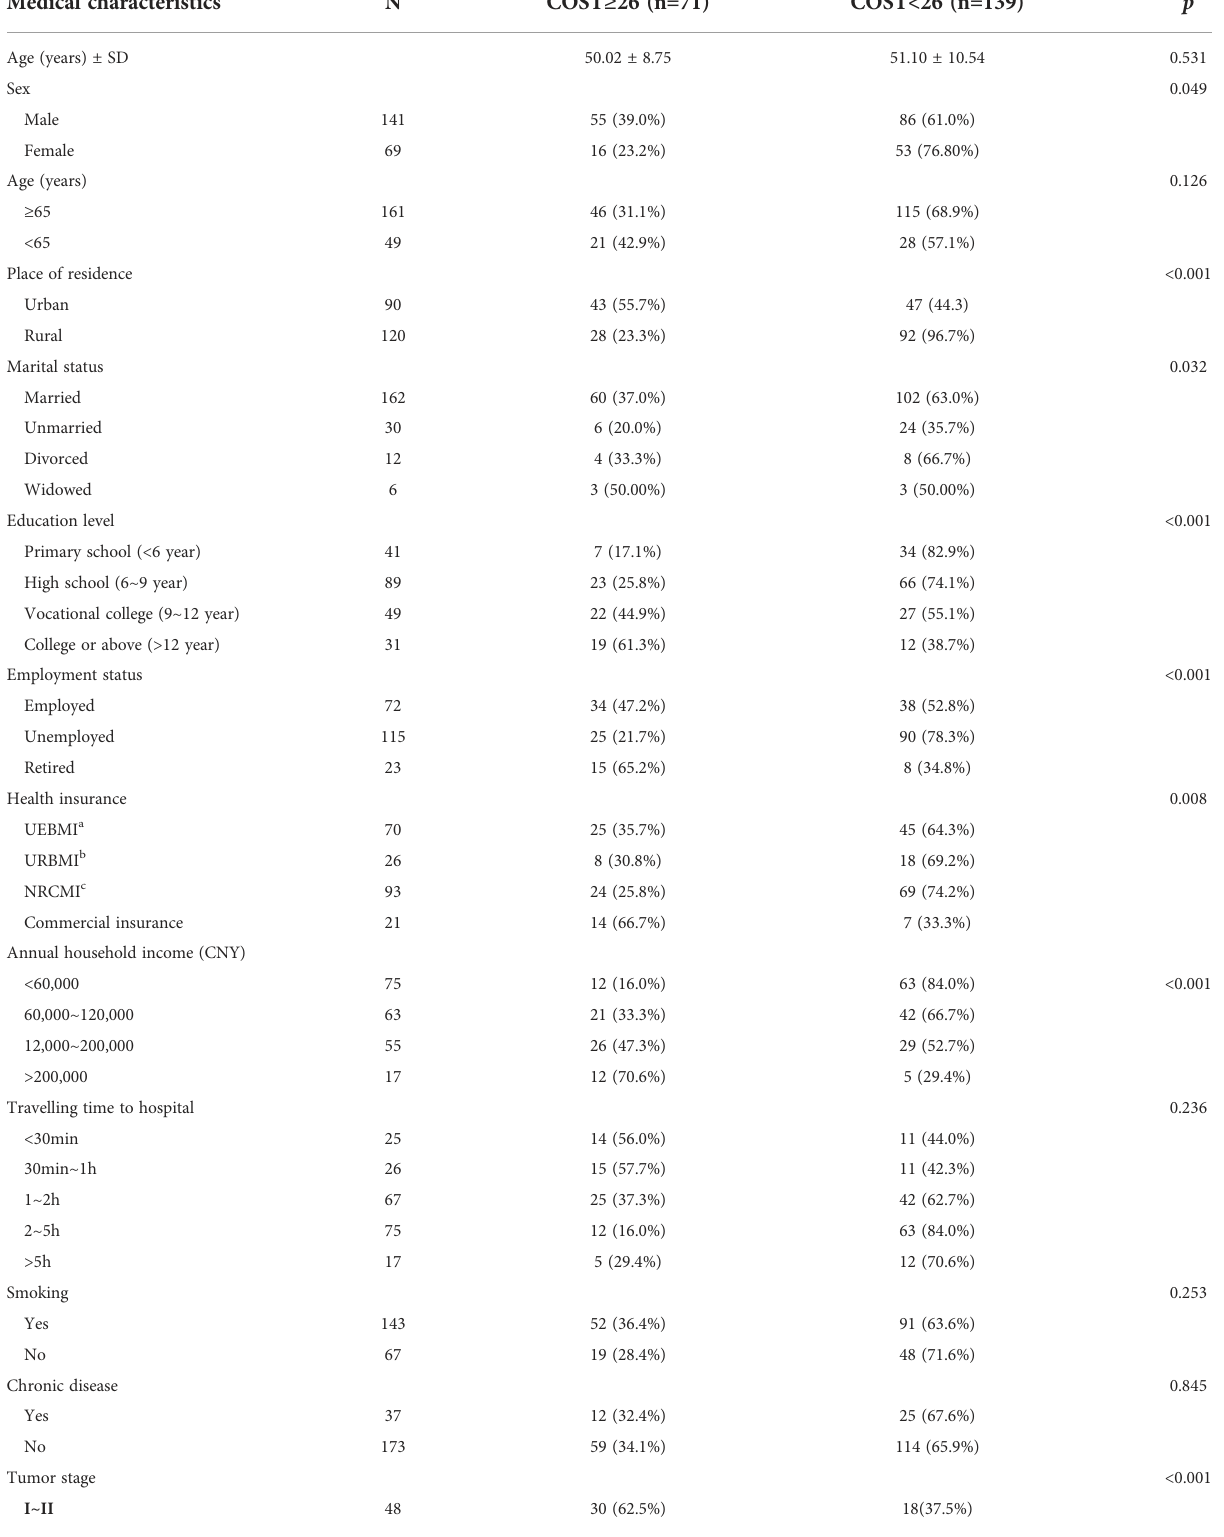
TABLE 1 Patients characteristics by COST score ( N